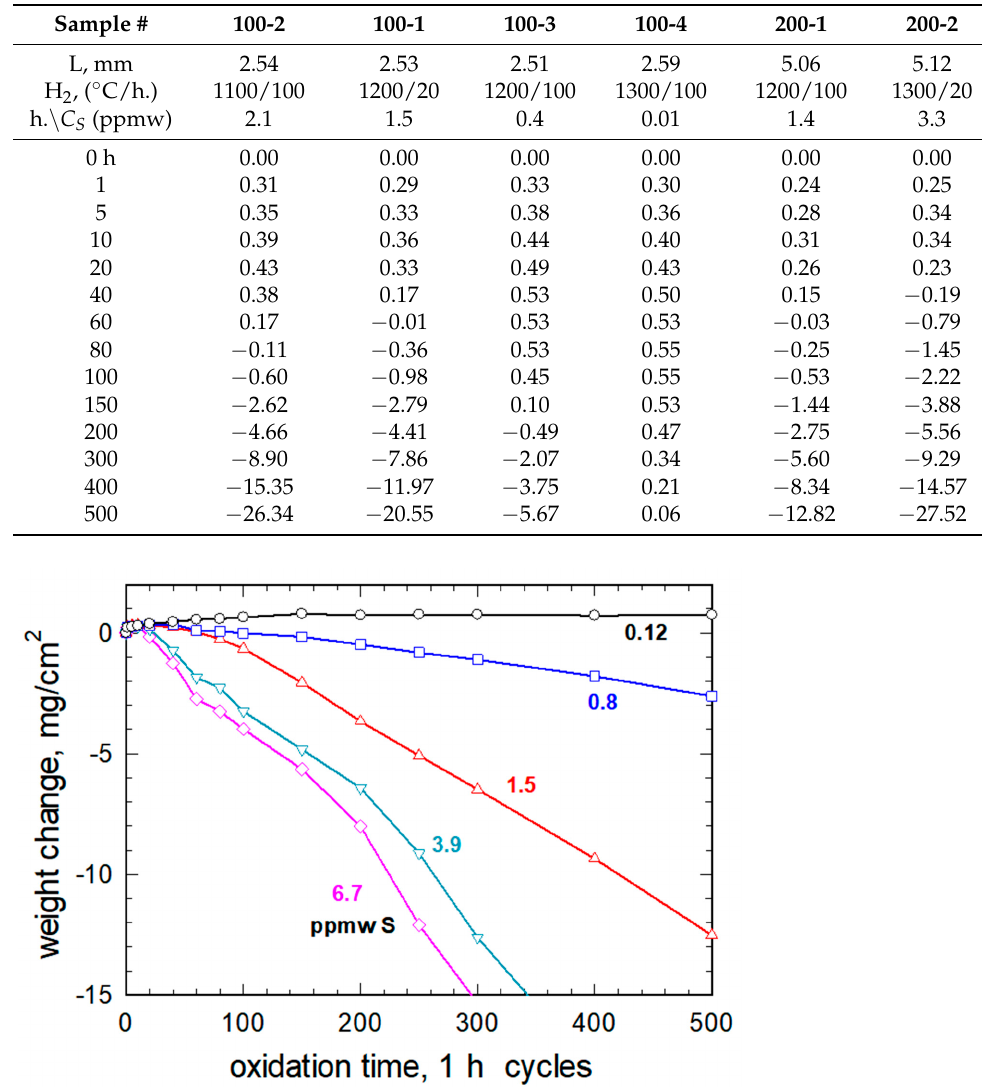
Table 4. Cyclic-oxidation specific weight change data for “100 mil” and “200 mil” PWA 1480 samples